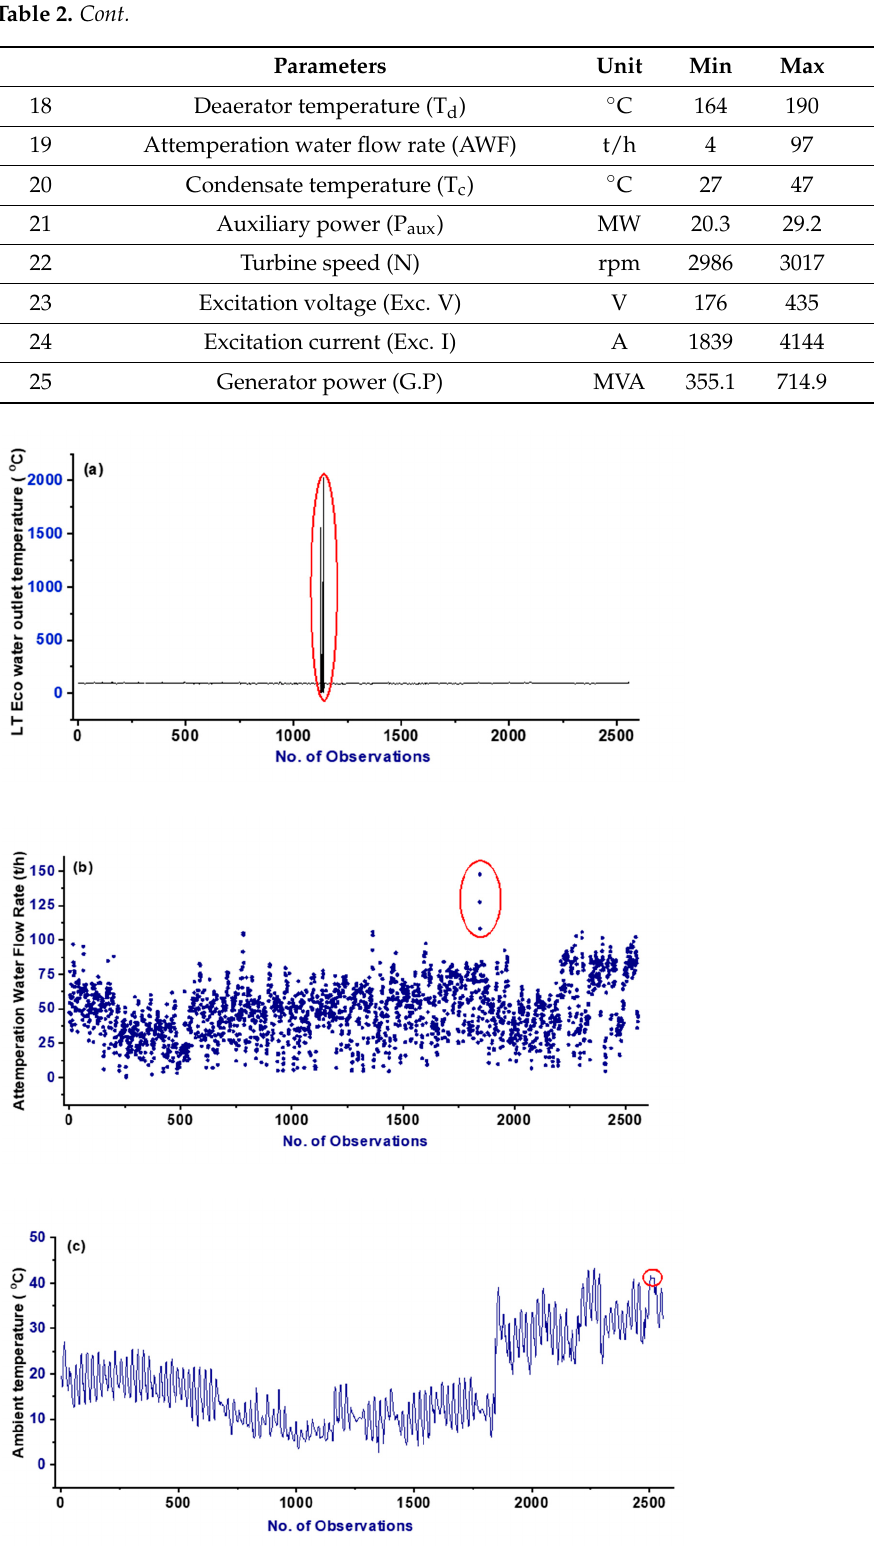
Figure 3. Data cleaning of the operation parameters: ( a ) removal of fluctuating faulty observations caused by sensor’s fault; ( b ) outlier removal; ( c ) removal of fixed values of observations caused by sensor’s fault. Finally, the list of the thermo-electric operating parameters (1st–24th) and generator power (25th) with their operating ranges is given in Table 2. The operating ranges of the thermo-electric operating parameters were established after the extensive data processing techniques and are comparable to those reported in literature studies. [3,33]. Moreover,